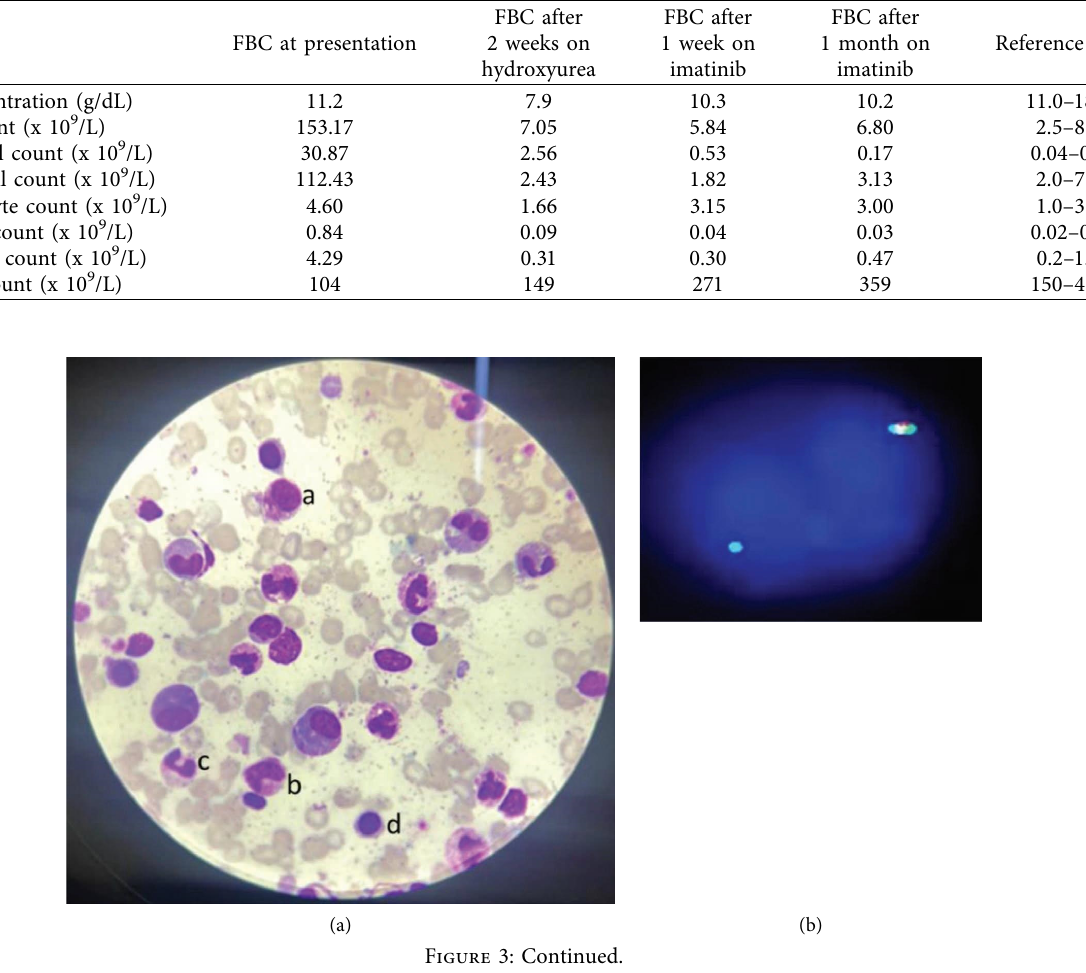
Figure 2: Echocardiogram 5 weeks post imatinib: (a) 2D parasternal long axis view showing dilated left ventricle, left atrium and thickened Table 1: Series of full blood count results showing response to